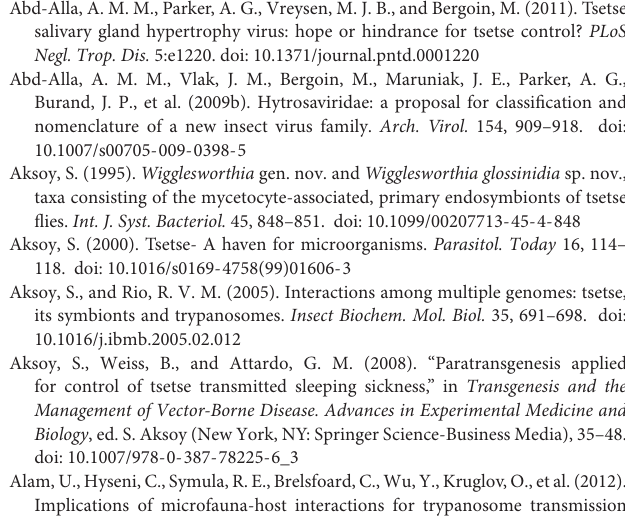
Supplementary Figure 1 | Relative density of GpSGHV in six taxa of tsetse flies over days post injection. Transformed GpSGHV density for six taxa of tsetse flies injected with GpSGHV normalized against control flies. Total DNA was extracted from six females and two males at 1, 5, and 9 days post injection and used as template for qPCR. Data were normalized to the housekeeping β -tubulin gene, against time zero and against the control injected flies at each time point and transformed based on the Box-Cox lambda value. The linear regression line was calculated using the lm method in R. Supplementary Figure 2 | Heatmap indicating the relative density of tsetse endosymbionts Wigglesworthia (A) , Sodalis (B), and Wolbachia (C) between males and females in adult tsetse flies of six species injected with